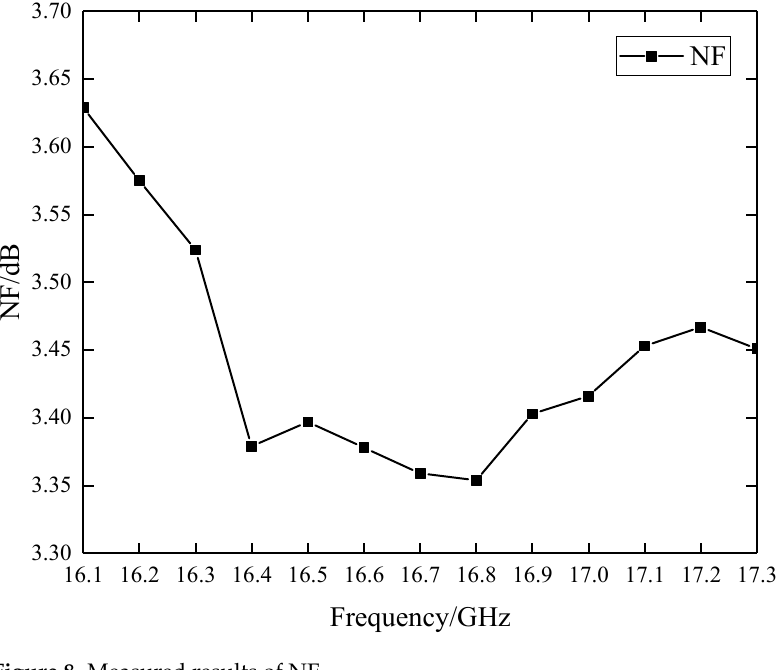
Figure 8. Measured results of NF.